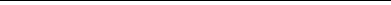
conjugation symbol F , which when applied to an SU(2) multiplet of scalar (cid:12)elds is de(cid:12)ned (cid:2) (cid:3) T by (cid:8) F (cid:8) y , where the dagger refers both to hermitian conjugation of the (cid:17)